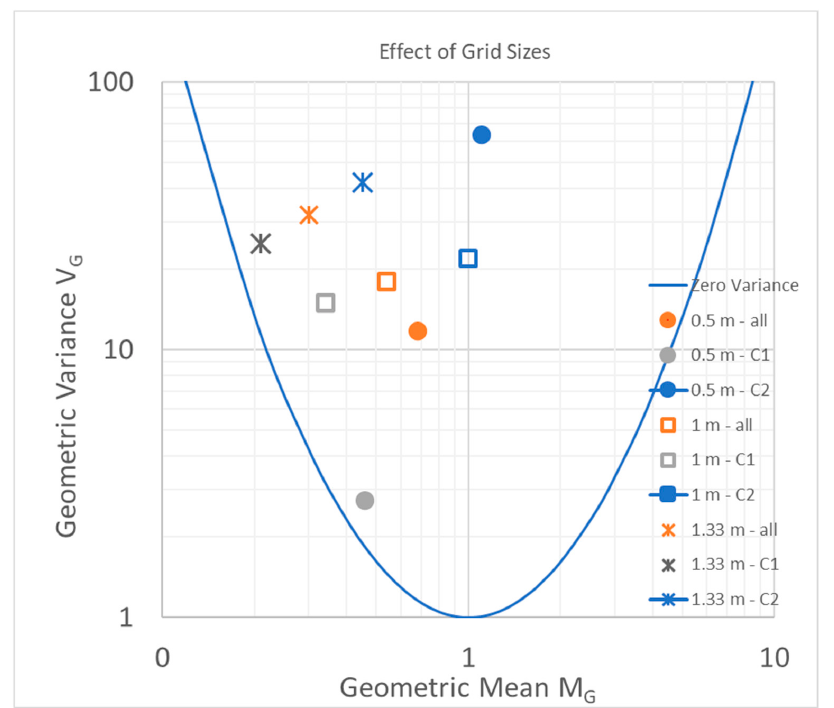
Figure 7. Results of direct dispersion–explosion simulation using three grid sizes from the Blast and Fire for Topside Structure joint industry (BFTSS) Phase 3B project report. Grid size refers to grids outside the local refinement region round the release source. Note about legend: a line is added to the start of a new symbol to allow its easy identification.